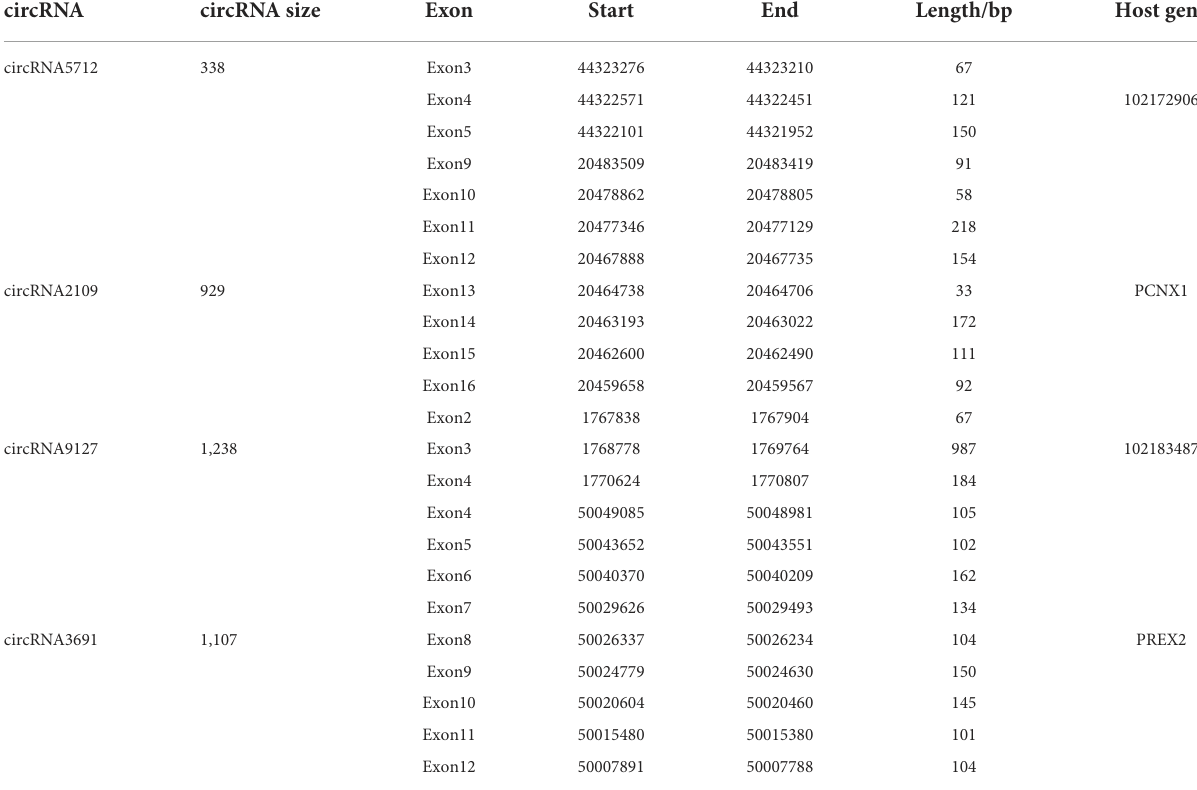
TABLE 2 The structural composition of key circRNA in the development of secondary hair follicles in cashmere goat.